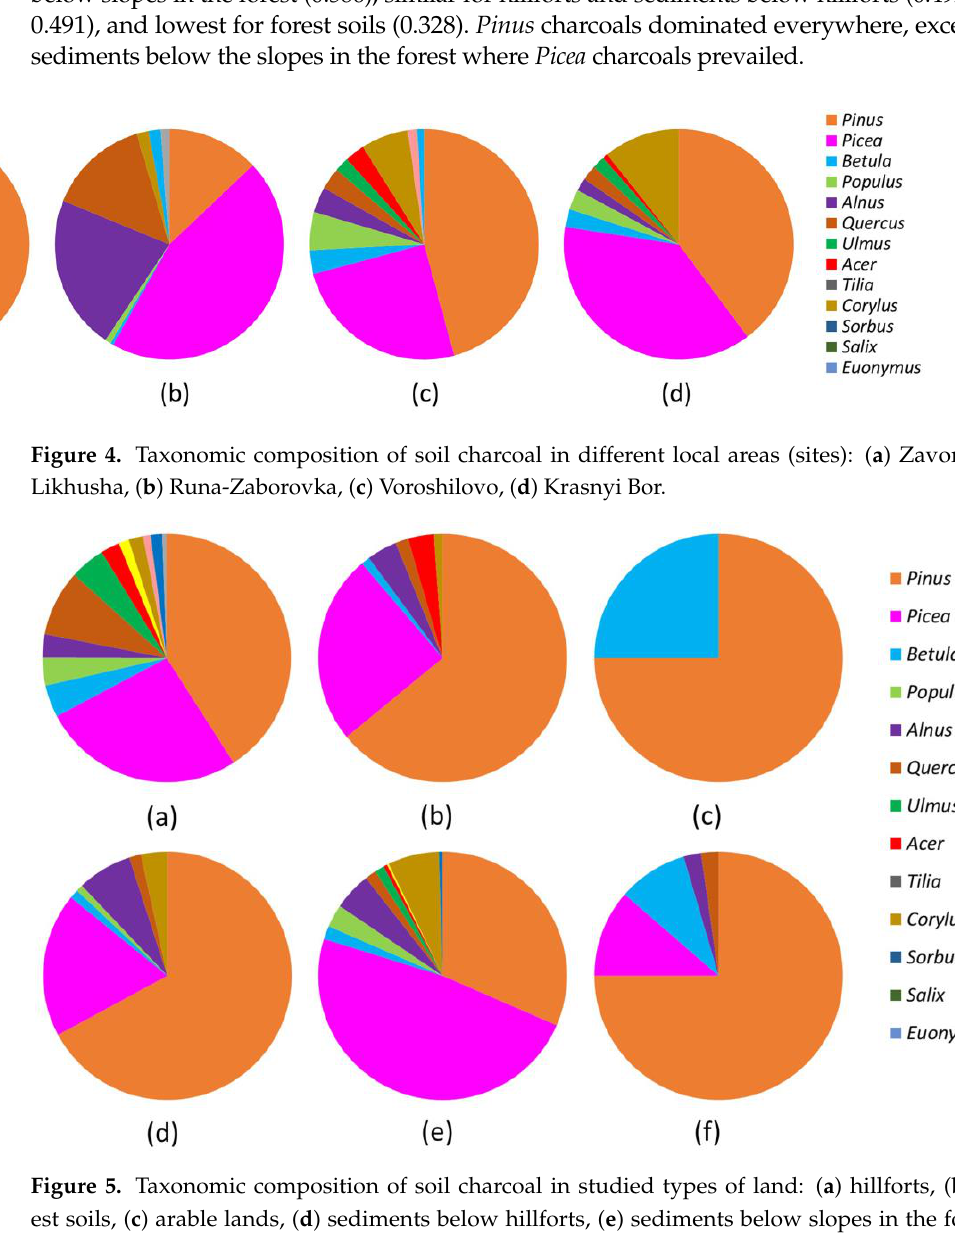
Figure 5. Taxonomic composition of soil charcoal in studied types of land: ( a ) hillforts, ( b ) forest soils, ( c ) arable lands, ( d ) sediments below hillforts, ( e ) sediments below slopes in the forests, ( f ) vegetable gardens.